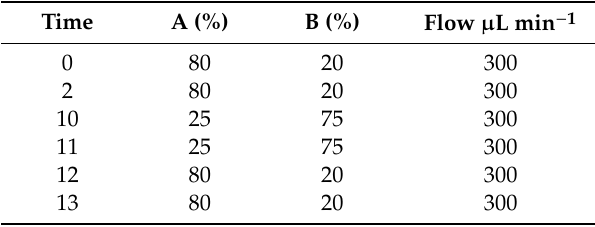
Table 1. Liquid chromatography (LC) solvent gradient